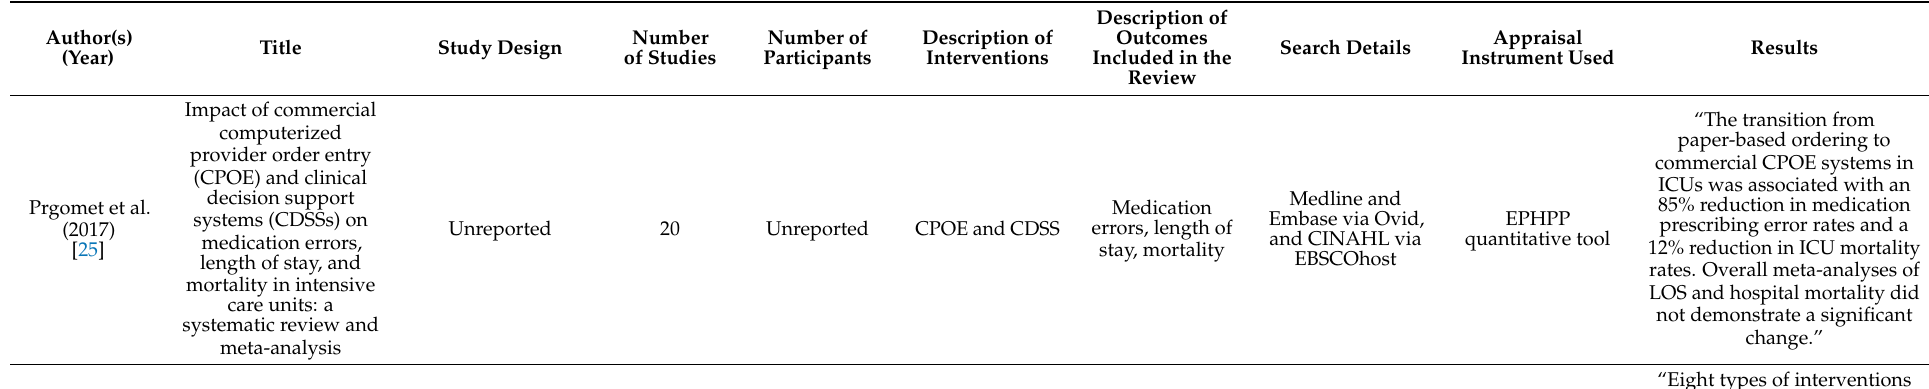
Table 1. Summary of